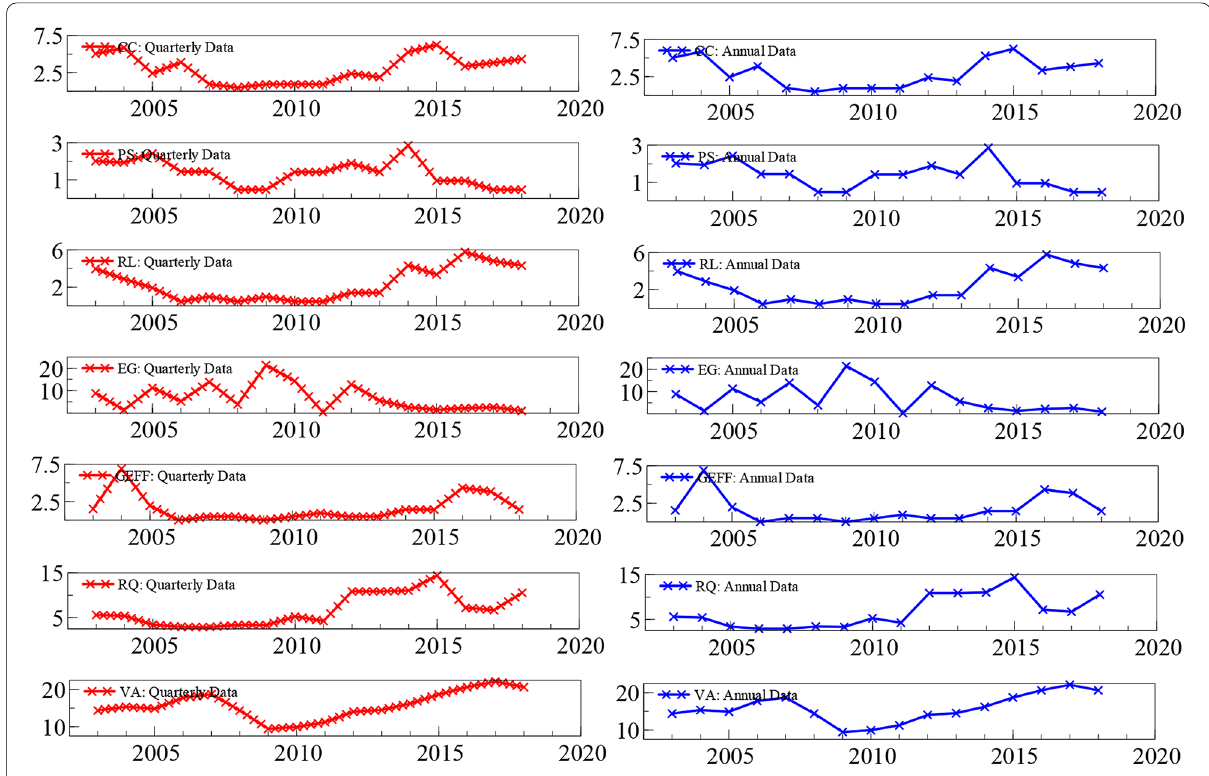
Fig. 1 Comparative plots of annual and quarterly